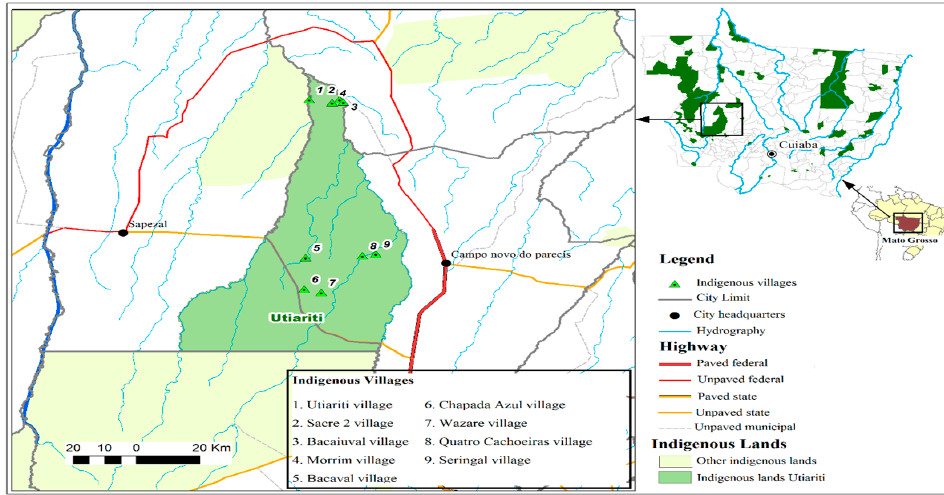
Figure 1. Geographical location of Mato Grosso Indigenous lands, highlighting Utiariti Indigenous land and nine villages of the Haliti-Paresí community in the southeastern region of the Brazilian Amazon, 2014–2015.